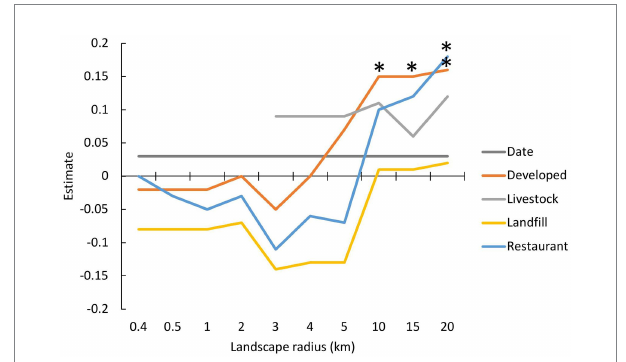
FIGURE 2 Effect sizes and significance of explanatory variables in models of the plastic content of black vulture ( Coragyps atratus ) and turkey vulture ( Cathartes aura ) pellets in the Charlotte Metropolitan Area, USA. Significant ( p < 0.05) effects are labeled with an asterisk. Commercial food provider density (“Restaurant”), livestock and game producer density (“Livestock”), and amount of developed landcover (“Developed”) were measured in landscapes of varying radii surrounding pellet collection sites. Distance from pellet collection sites to the nearest landfill is labeled as “Landfill.” For variables that were included in more than one model at the same scale, the estimate from the best performing model was used. All models also included a site variable to account for the non-independence of pellets collected at the same